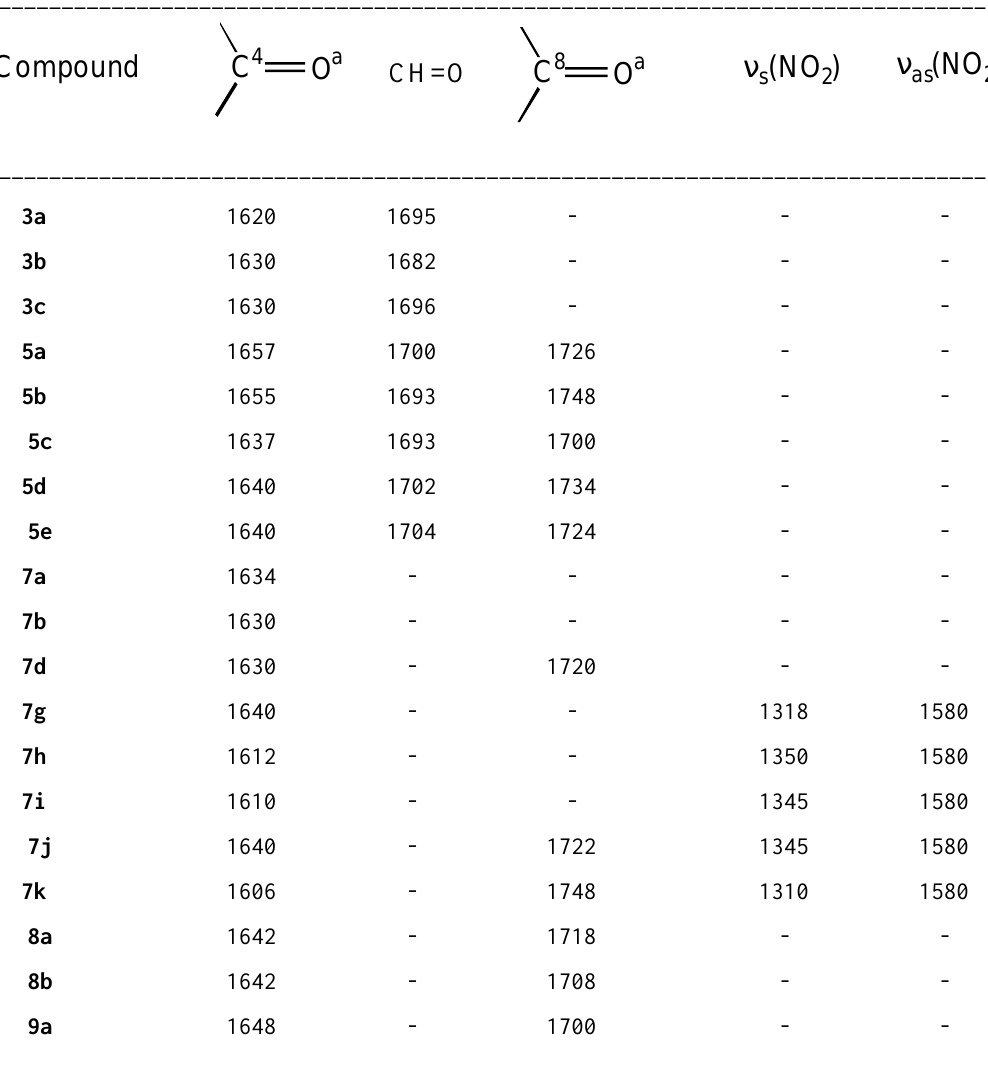
Table 2. IR - spectral data (in cm -1